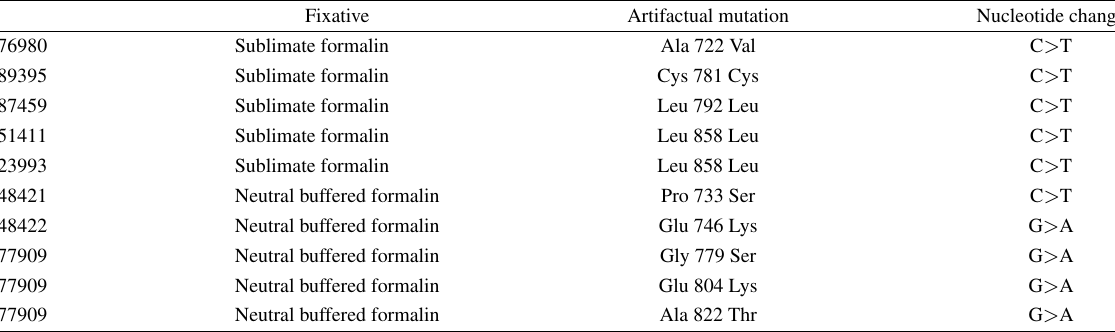
Types of artifactual mutations detected in DNA from fixed paraffin embedded